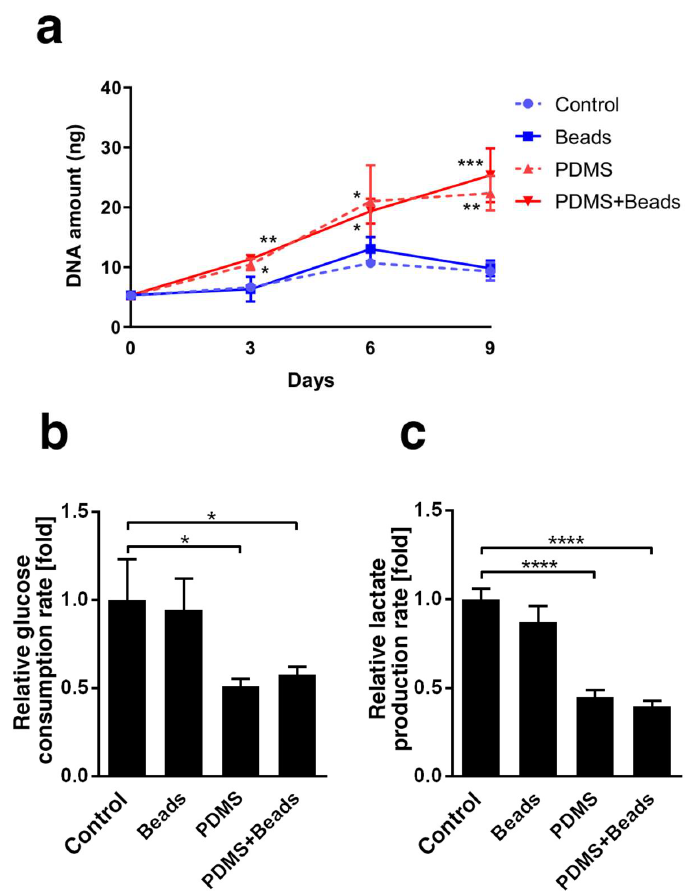
Figure 2. DNA content, glucose consumption and lactate production of spheroids. ( a ) DNA was extracted from 10 spheroids and measured at days 0, 3, 6 and 9. Blue and red represent polystyrene or gas-permeable conditions, respectively. Broken and solid lines represent normal or hydrogel bead-embedded spheroids. ( b ) Glucose consumption rate was calculated at day 3 and expressed as fold-change relative to Control condition. ( c ) Lactate production rate was calculated at day 3 using the same samples as for glucose consumption. * p < 0.05, ** p < 0.01, *** p < 0.001, **** p < 0.0001.